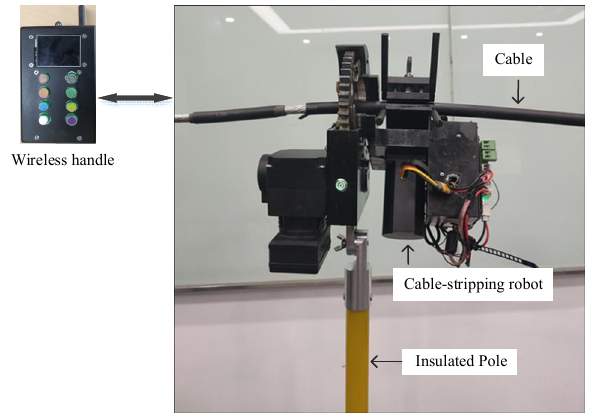
Figure 7. Experimental setup of the cable-stripping robot.